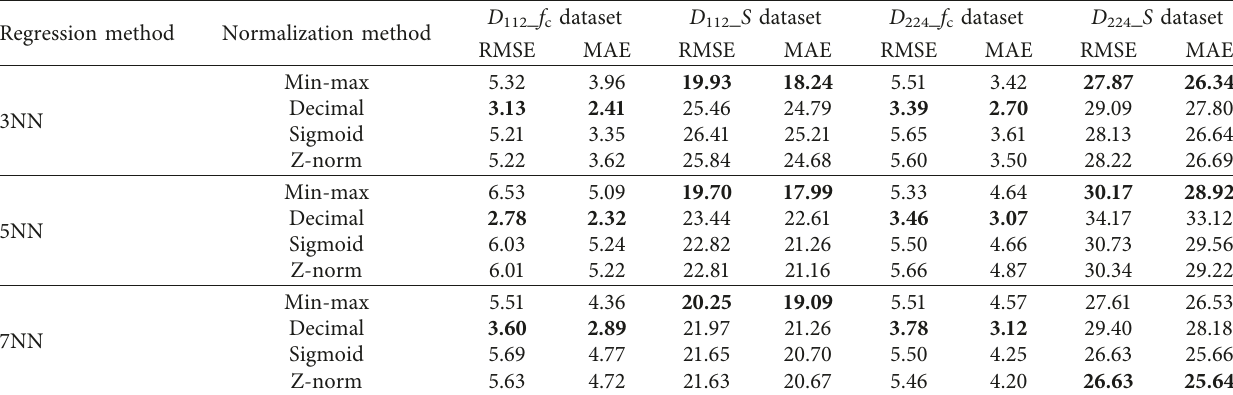
Figure 3: Box-plot graphs for the raw and decimal normalized dataset. Table 5: The results of the normalization methods.